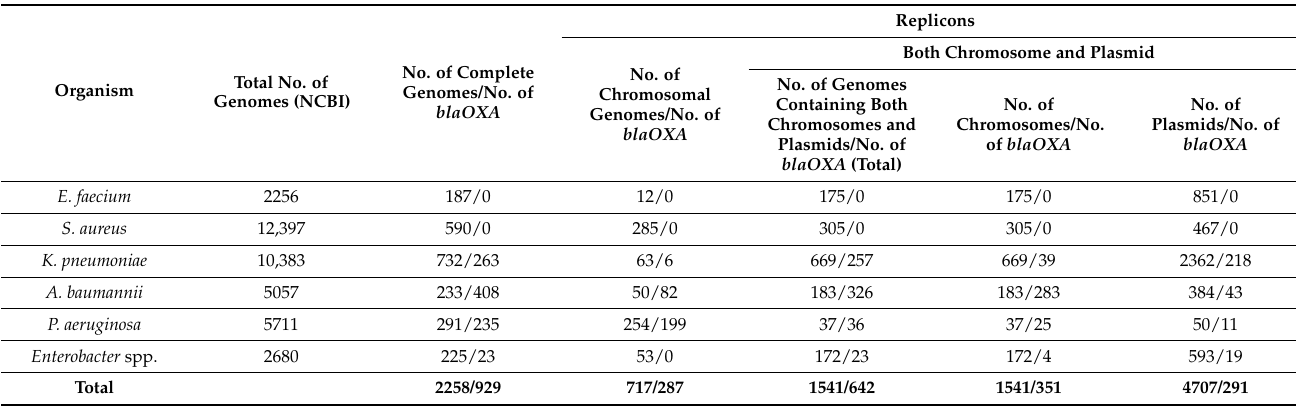
Table 1. Number of genomes of ESKAPE pathogens found in NCBI Genome Database and statistics of blaOXA found